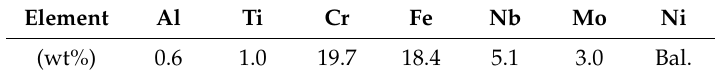
Table 2. Selective laser melting (SLM) manufacturing parameters.